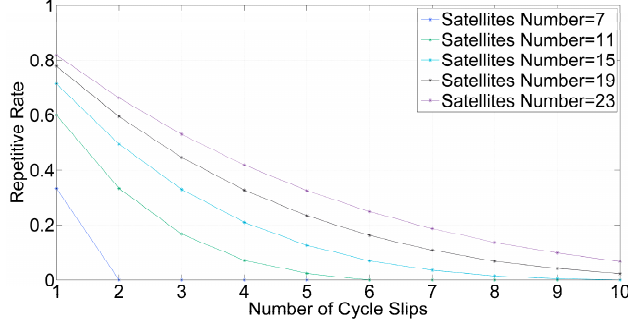
Figure 2. Repetitive Rate under Different Numbers of Satellites and Cycle Slips.